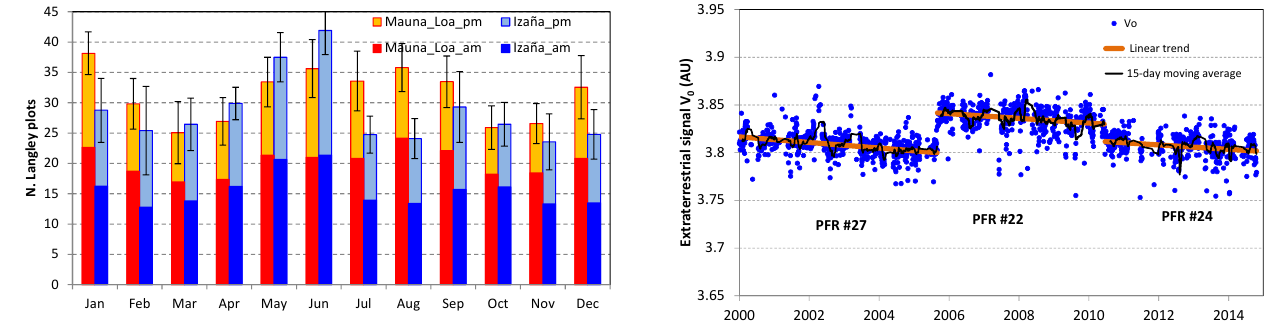
Figure 4. Daily extraterrestrial voltages ( V 0 ) at the 500nm wave- length obtained with the Langley plot method for the GAW-PFR at Mauna Loa (morning calibrations only). The temporal linear fit to the V 0 ’s for each instrument deployment, as well as the 15-day moving average, is superimposed. Note that these are instrument signals; i.e., they depend on each particular instrument and are not directly